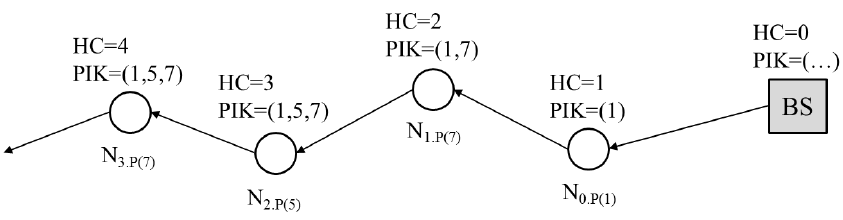
Figure 2. Flooding control message.